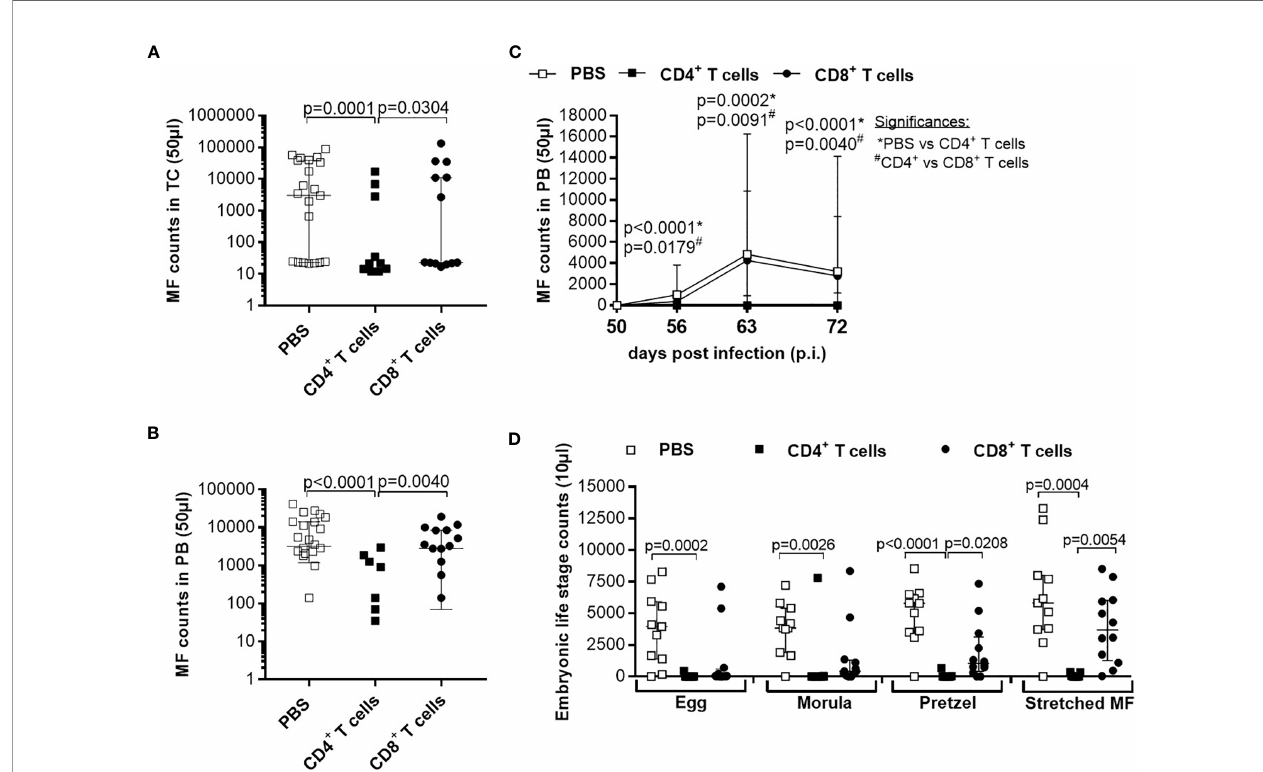
FIGURE 3 | Adoptive transfer of naïve CD4 + T cells impair embryogenic stage development accompanied with reduce micro fi lariae release. Micro fi laria (MF) counts from RAG2IL-2R g -de fi cient C57BL/6 mice that were adoptively transferred with CD4 + or CD8 + T cell from naïve C57BL/6 donor mice were determined in the (A) thoracic cavity (TC) and (B) peripheral blood (PB) on day 72 p.i. and (C) during the course of infection in PB upon 50 days p.i. Moreover, female adult worms were analysed to determine (D) embryonic stages. Graphs show dot blots with median and interquartile ranges. (A – C) Results are pooled from four independent experiments including no adoptive transfer (PBS; n=25) and adoptive transfer of CD4 + (n=21) and CD8 + T cell (n=17) into RAG2IL-2R g -de fi cient C57BL/6 mice. (D) Results are from one experiment including n=9, n=6 and n=11 individual worms from no adoptive transferred (PBS; n=5) and CD4 + (n=6) and CD8 + T cell (n=6) adoptive transferred RAG2IL-2R g -de fi cient C57BL/6 mice, respectively. Signi fi cant differences between the groups were determined by Kruskal-Wallis-test followed by a Dunn ’ s multiple comparison